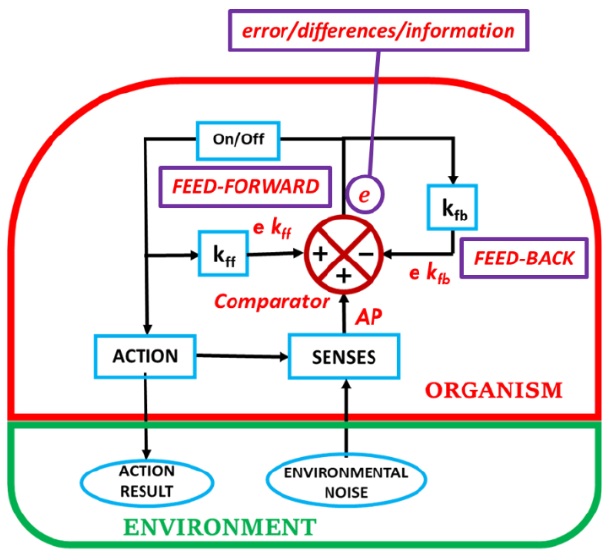
Figure 1. Schematic of a living being in its environment. Ontogenetic feedback–feedforward control reflex-actions keep the internal milieu of the living being within homeorhetic bounds. In order to clarify Bateson’s difference which makes a difference, consider the beginning of the LB/E cyclic interactions as the detection of environmental noise by the senses of the LB. This is the only window that the LB/E has to access the E. The primary motivation of the LB/E in sensing the noisy environment is to maintain and satisfy its physiological and/or relational needs [8–12]. This self-referential, recursive process leads to the LB/E finding meaning in its circumstances. Two essential connections define the asymmetrical relationship between the LB and its E. First, a single sense element serves as intermediary between the external environ- ment and the internal milieu of the LB. Interactions result in an electrical signal or action potential (AP), which is used by the LB to generate self-referenced information, by way of the comparator, as a difference which makes a difference. The comparator uses feed- back and feedforward circuits incorporating quantities k fb and k ff , respectively, to modify error/difference/information, e